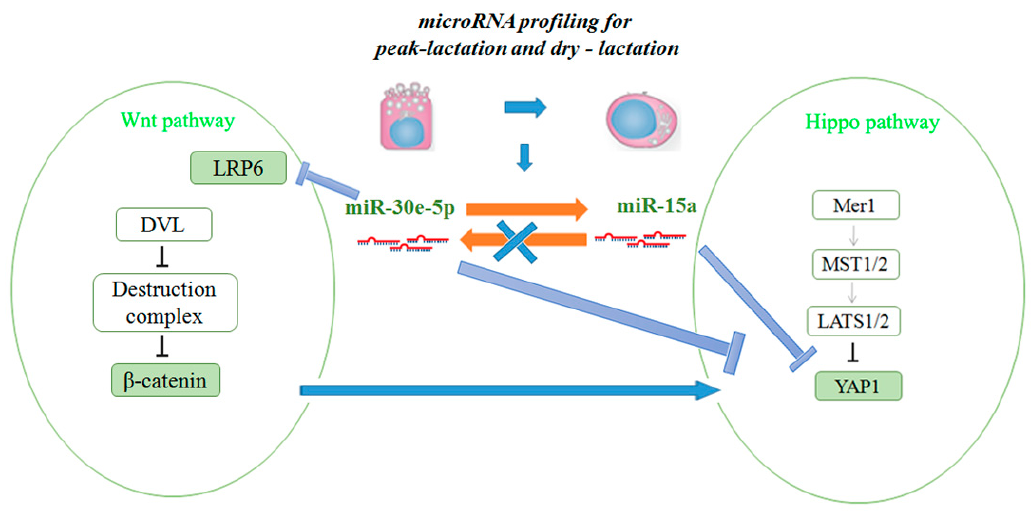
Figure 10. Diagram summarizing our findings: miR-30e-5p and miR-15a synergistically regulate fat metabolism via LRP6 and YAP1 in goat mammary epithelial cells.